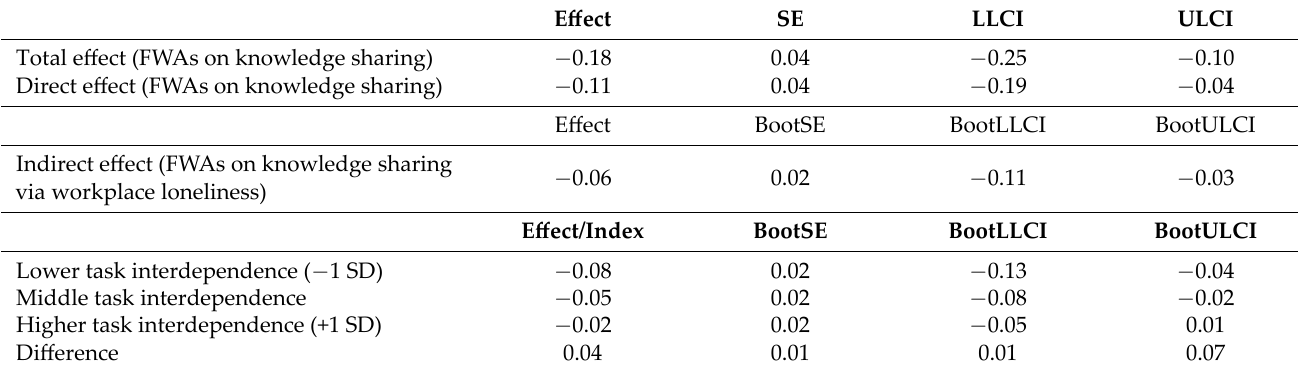
Table 3. Mediation effect and moderated mediation analyses of Study